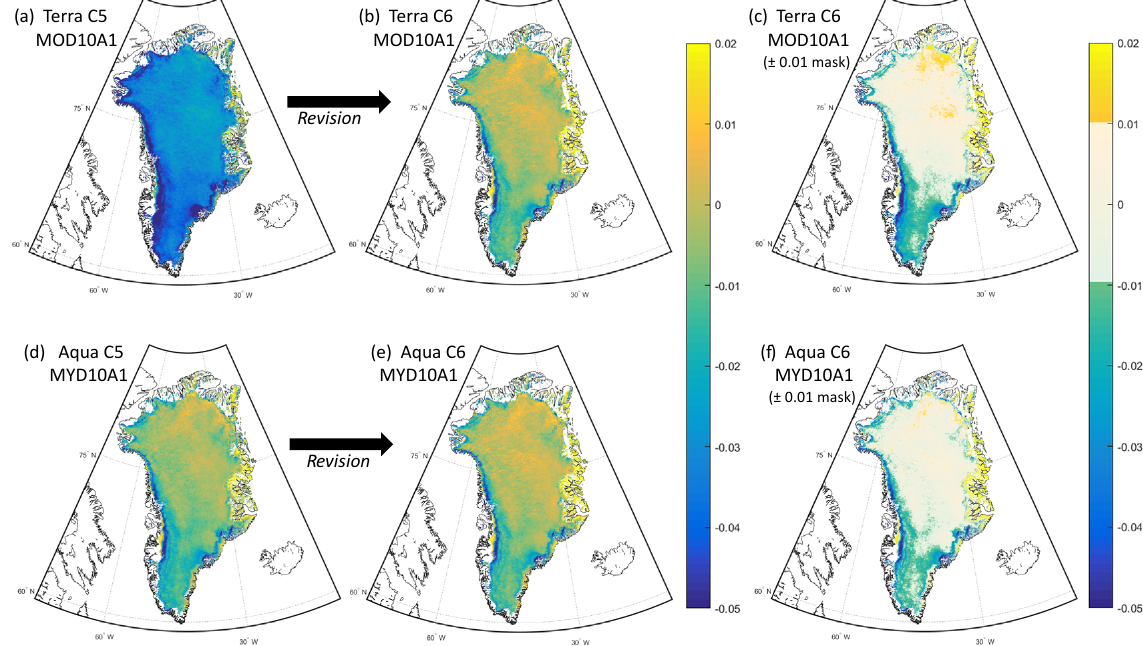
Figure 5. Maps (a, b) depict Terra MOD10A1 C5 and C6 2002–2016 decadal trend in broadband albedo. Maps (d, e) depict Aqua MYD10A1 C5 and C6 2003–2016 decadal trend in broadband albedo. Maps (c, f) show the same C6 decadal Terra and Aqua trends, respectively, with the sensor trends of ± 0.01decade − 1 masked out as white to visualize trends in albedo that are larger than expected sensor calibration uncertainty, including albedo decline (southeast and periphery GrIS) and albedo increase (northeast